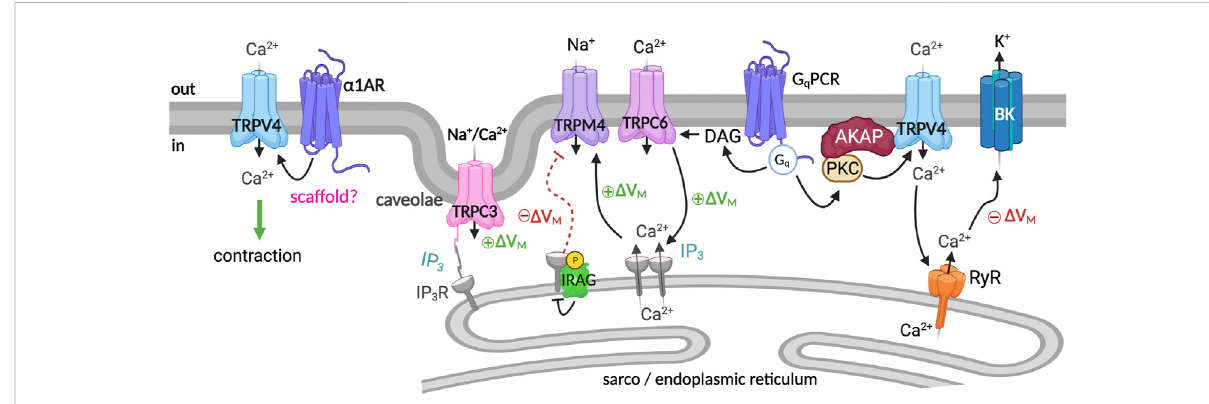
FIGURE 2 TRP channel signaling complex regulates VSM contractility. Several TRP channels are involved in regulating VSM excitability. Caveolae scaffolding protein caveolin-1 (cav-1) co-localizes the IP 3 R1 and TRPC3 channels close to each other. IP 3 — induced coupling of IP 3 R1 and TRPC3 leads to TRPC3 activation and VSM depolarization (Xi et al., 2008; Adebiyi et al., 2011). TRPC6/TRPM4, PLC γ 1, and IP 3 R are part of a stretch- sensing signaling molecular complex that translates pressure-induced mechanical stimuli into VSM membrane depolarization (Reading and Brayden, 2007; Gonzales et al., 2014). PLC activation generates IP 3 , which sensitizes IP 3 Rs to TRPC6-mediated Ca 2+ in fl ux boosting SR Ca 2+ release through